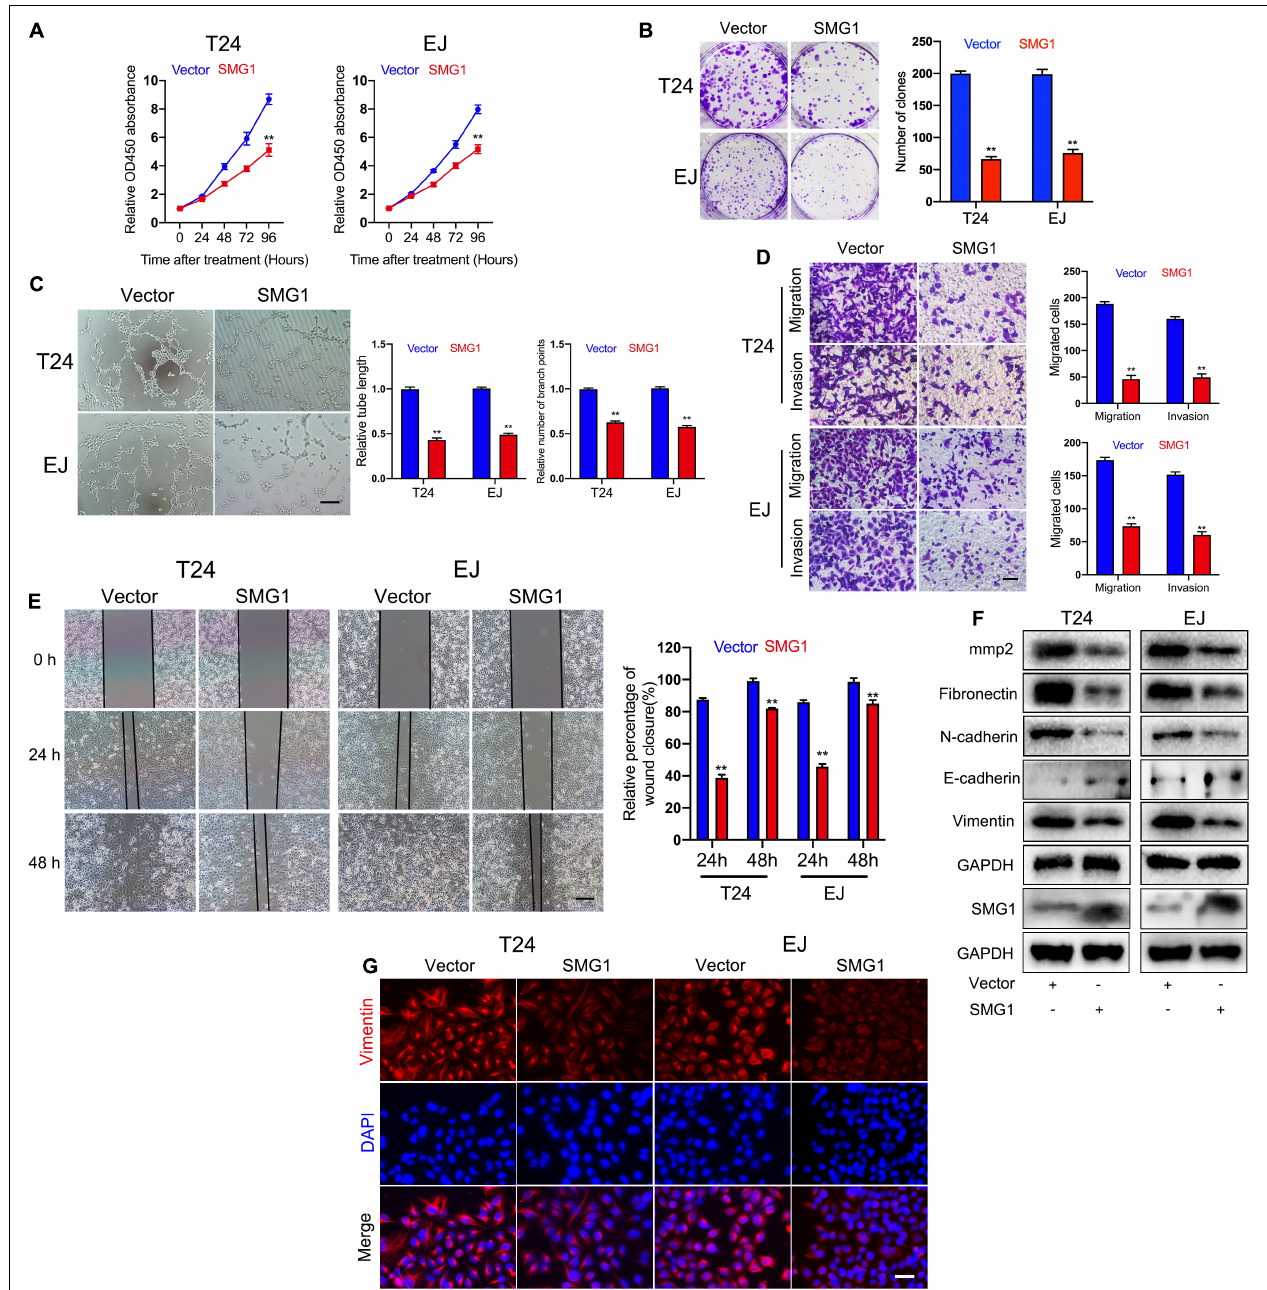
FIGURE 6 | SMG1 serves as a tumor suppressor in bladder cancer cells. (A) SMG1 inhibited cell viability in T24 and EJ cells. (B) Colony formation assay was performed in bladder cancer cells transfected with vector or SMG1 plasmid. (C) Tube formation assay indicated that SMG1 was involved in tumor angiogenesis. Scale bars, 400 µ m. (D,E) Transwell migration, invasion assay, and cell scratch assay showed the biological functions of SMG1. Scale bars, 200 and 400 µ m, respectively. (F) Expression levels of SMG1, EMT-related genes, and MMP2 were determined by western blotting. (G) Immunofluorescence detection of vimentin in control and SMG1-overexpressing bladder cancer cells. Scale bars, 200 µ m. * p < 0.05, ** p < 0.01 vs. control